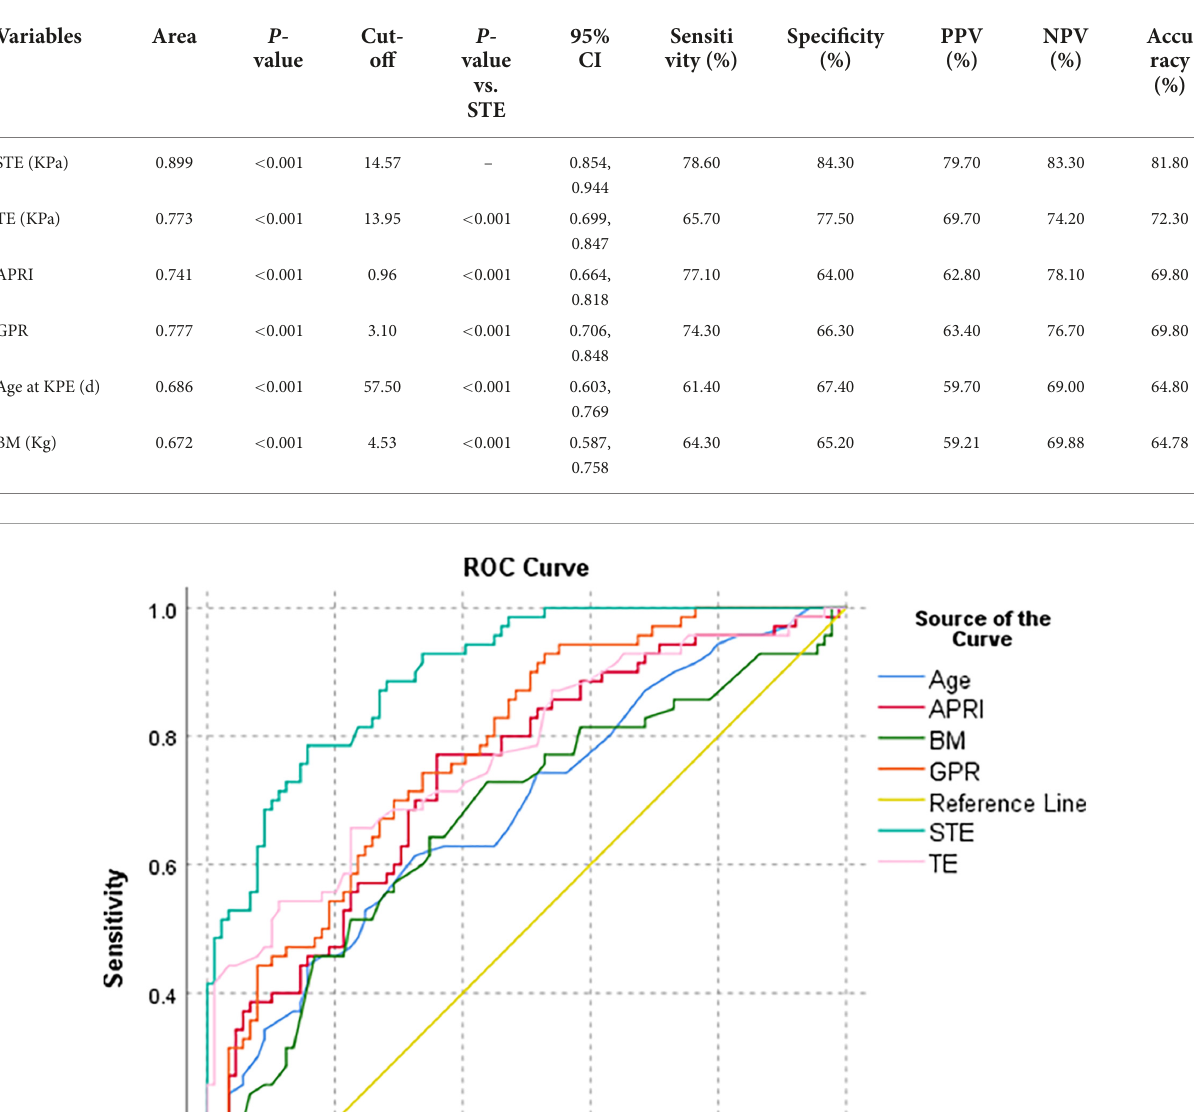
TABLE 3 Diagnostic performance of various variables in children with biliary atresia with cirrhosis.